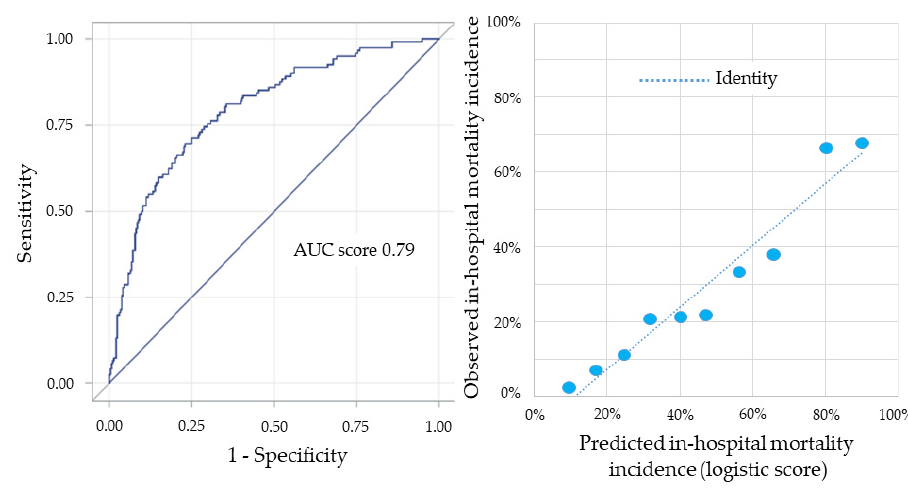
Figure 4. Left panel: receiving operating characteristic curve and corresponding area under the curve (AUC) for in-hospital mortality prediction of the risk score. Right panel: concordance between the in-hospital mortality incidence predicted by the score and that observed in the entire population, stratified by deciles of risk.